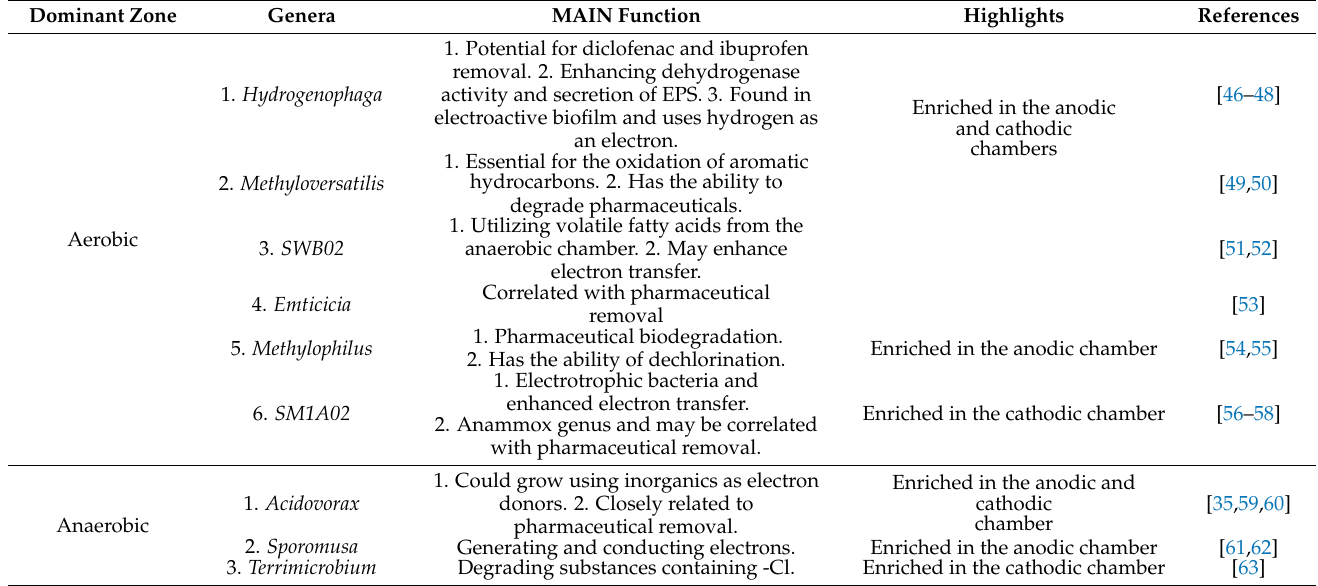
Table 4. The genera in the dominant zones and their proposed